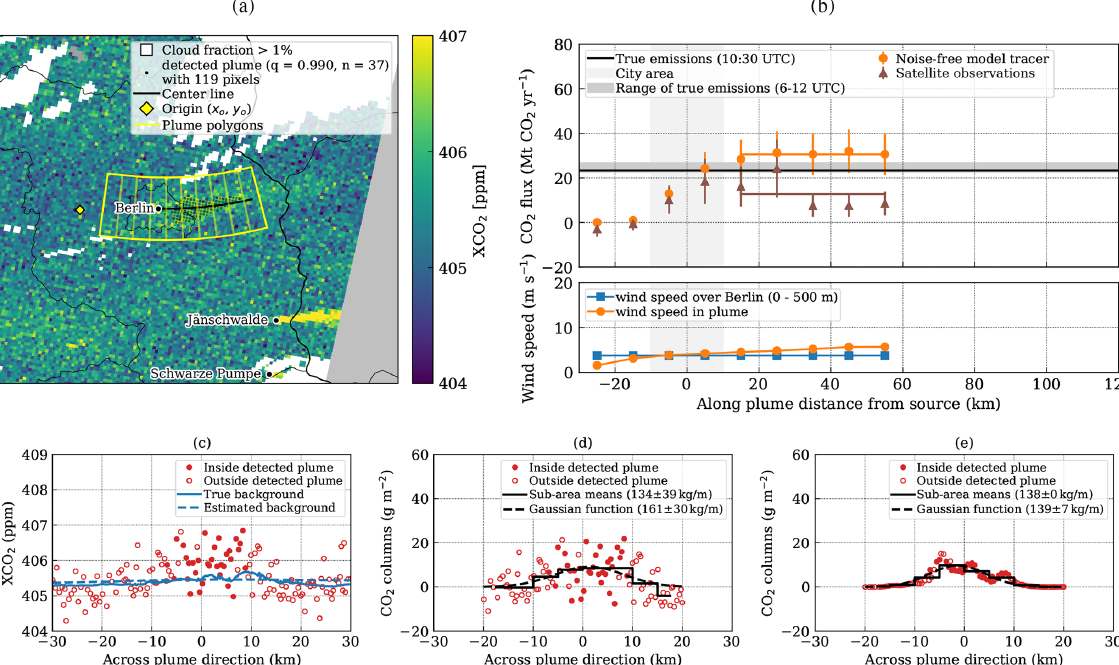
Figure 4. Illustration of the mass-balance approach applied to a plume on 23 April 2015 observed with low-noise CO 2 observations. (a) De- tected XCO 2 plume with polygons used for computing the line densities. (b) CO 2 flux and wind speed as a function of along-plume distance. The CO 2 fluxes estimated from the line densities are shown as markers with their uncertainty for the noise-free model tracer and the synthetic satellite observations. The horizontal lines show true emissions of Berlin at 10:30UTC (black line) and the estimated emissions. The extent of the city is highlighted by the light gray area. (c) XCO 2 satellite observations as a function of across-plume distance in the polygon between 10 and 20km downstream of the source. (d) Same as panel (c) but CO 2 column densities after subtracting the estimated background field. Sub-polygon means and Gaussian fit are also shown. (e) CO 2 column densities from the model tracer containing only emissions of